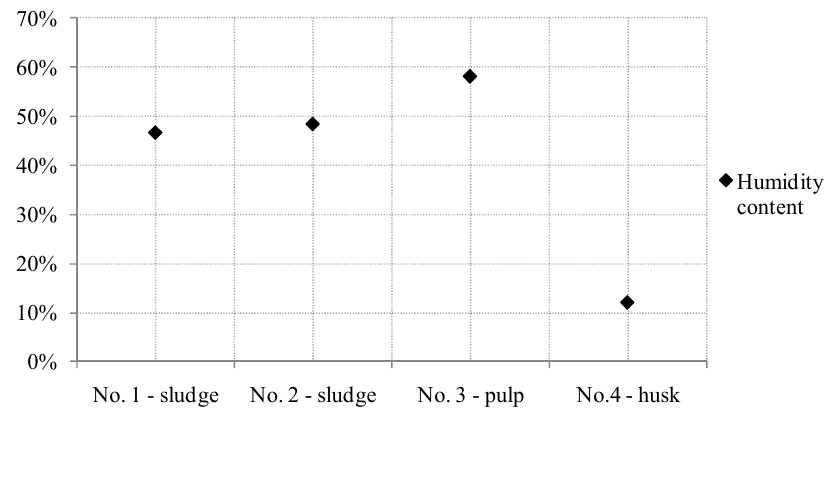
Figure 3. Average heat